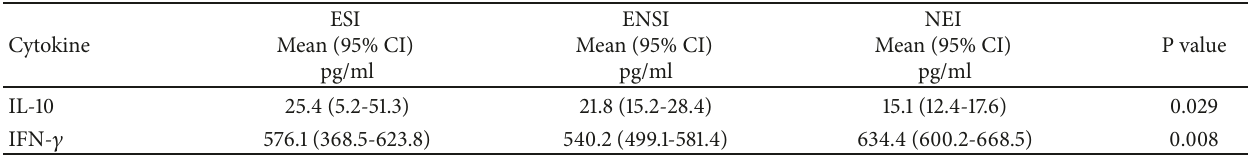
Table 2: Geometric mean of IL-10 and IFN- 𝛾 in exposed sensitized, exposed nonsensitized, and unexposed infants during clinical malaria episodes: Analysis of Variance